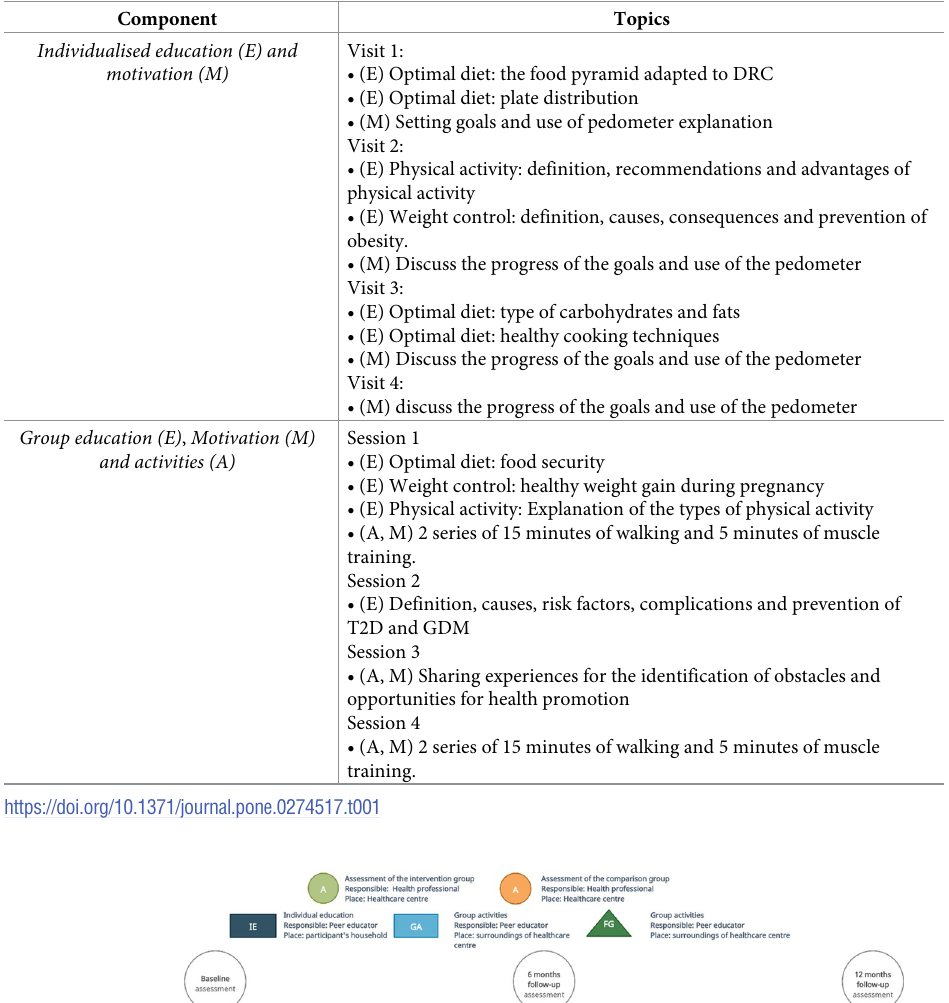
Table 1. Description of the multi-component health promotion programme.